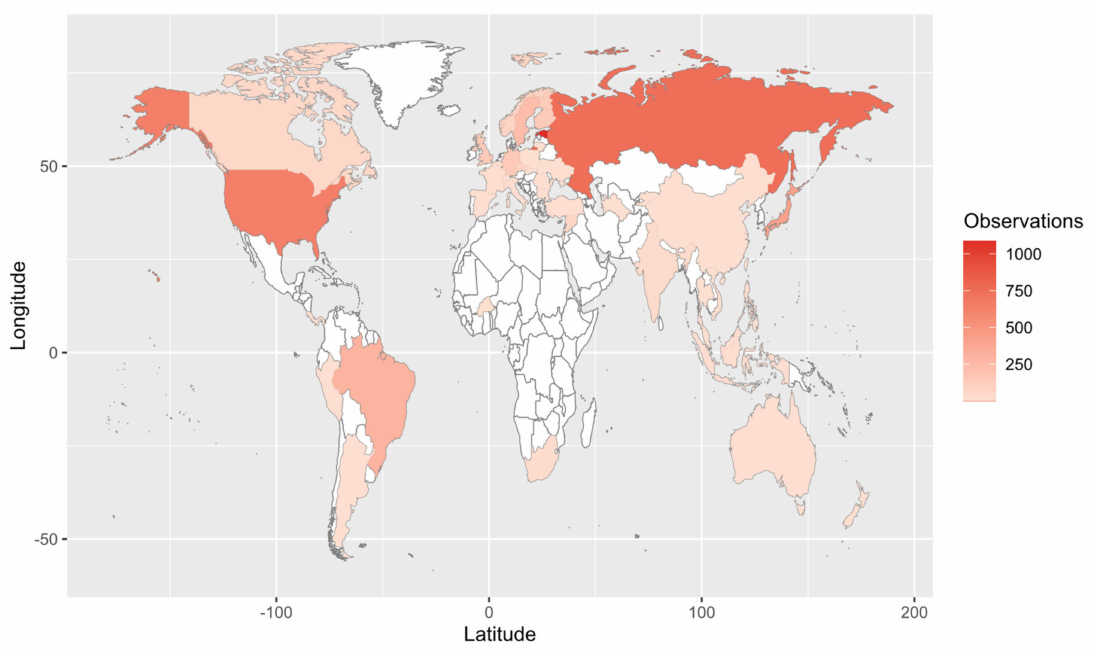
Figure 2. Map of field observations reported in the literature search. We reviewed 209 articles that comprised 6093 observations, of which 4287 are shown here (i.e., those with country-specific location information).